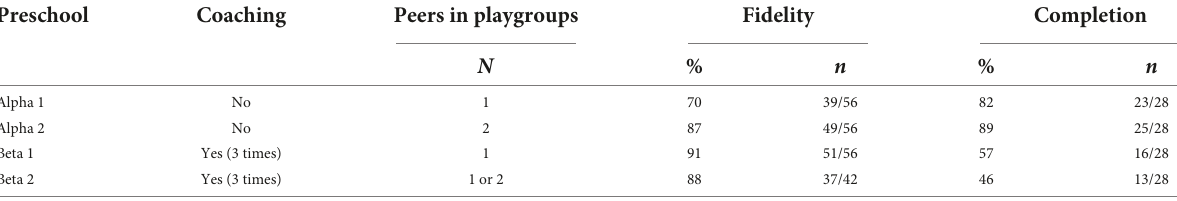
TABLE 4 Frequencies of fidelity and completion of PT/ST implementation in Swedish preschools ( N = 4). Preschool Coaching